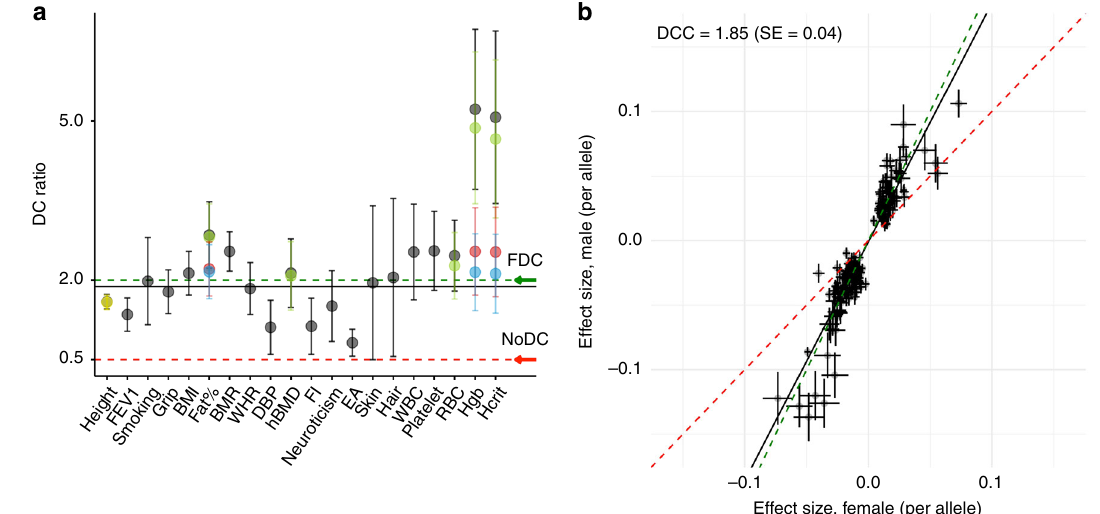
Fig. 1 Estimates of dosage compensation (DC) ratio and dosage compensation coef fi cient (DCC) for the UK Biobank (UKB) traits. a DC ratio with 95% con fi dence intervals (DC ratio + / − 1.96*SE) for 20 UKB traits as estimated using summary statistics from the association analyses. The black points indicate the DC ratio estimated using all SNPs on the X chromosome (non-pseudoautosomal region, non-PAR). For Height, Fat%, hBMD, RBC, Hgb and Hcrit the DC ratios are re-estimated excluding the SNPs in the regions of identi fi ed heterogeneity (Supplementary Table 4) and presented as coloured points (green: excluding region 1; yellow: excluding region 2; red: excluding region 3 or 4; blue: excluding region 1 and 3 or 4). The green and red dashed lines indicate the expectations under full DC (FDC) and lack of DC (No DC), respectively. The black solid line is the mean DC ratio ( = 1.88) after accounting for heterogeneity. b Male and female per-allele effect estimates (in standard deviation units) ( + /- SE) are compared for the lead SNPs identi fi ed in the combined discovery analysis ( M = 251). The SNPs located in the regions of heterogeneity for the six traits mentioned above are excluded. The green and red dashed lines indicate the expectations under FDC and no DC, respectively. The black line represents DCC (1.85, SE = 0.04). SE, standard error. M , number of lead SNPs. Traits: standing height (Height), forced expiratory volume in 1-second (FEV1), smoking status (Smoking), hand grip strength, right (Grip), body mass index (BMI), body fat percentage (Fat%), basal metabolic rate (BMR), waist to hip ratio (WHR), diastolic blood pressure (DBP), heel bone mineral density T-score (hBMD), fl uid intelligence score (FI), neuroticism score (Neuroticism), educational attainment (EA), skin colour (Skin), hair colour (Hair), white blood cell (leukocyte) count (WBC), platelet count (Platelet), red blood cell (erythrocyte) count (RBC), haemoglobin concentration (Hgb), Haematocrit percentage